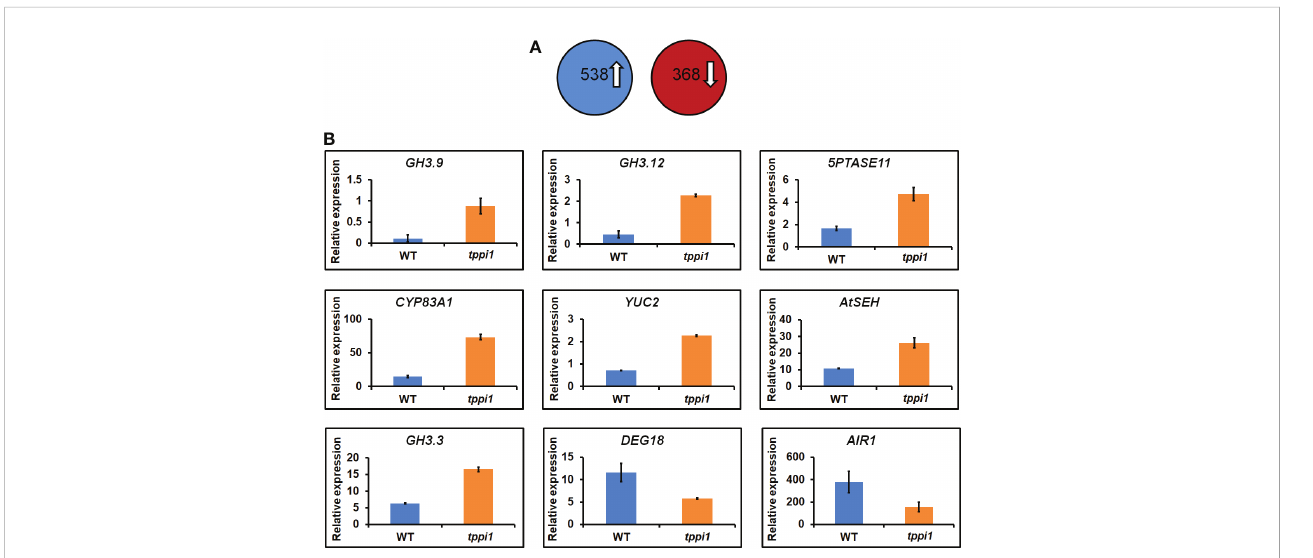
FIGURE 3 Transcriptome analysis of tppi1 mutant and WT plants root. (A) The number of up-regulated and down-regulated DEGs; (B) Relative expression of nine auxin-related genes including seven up-regulated and two up-regulated genes in